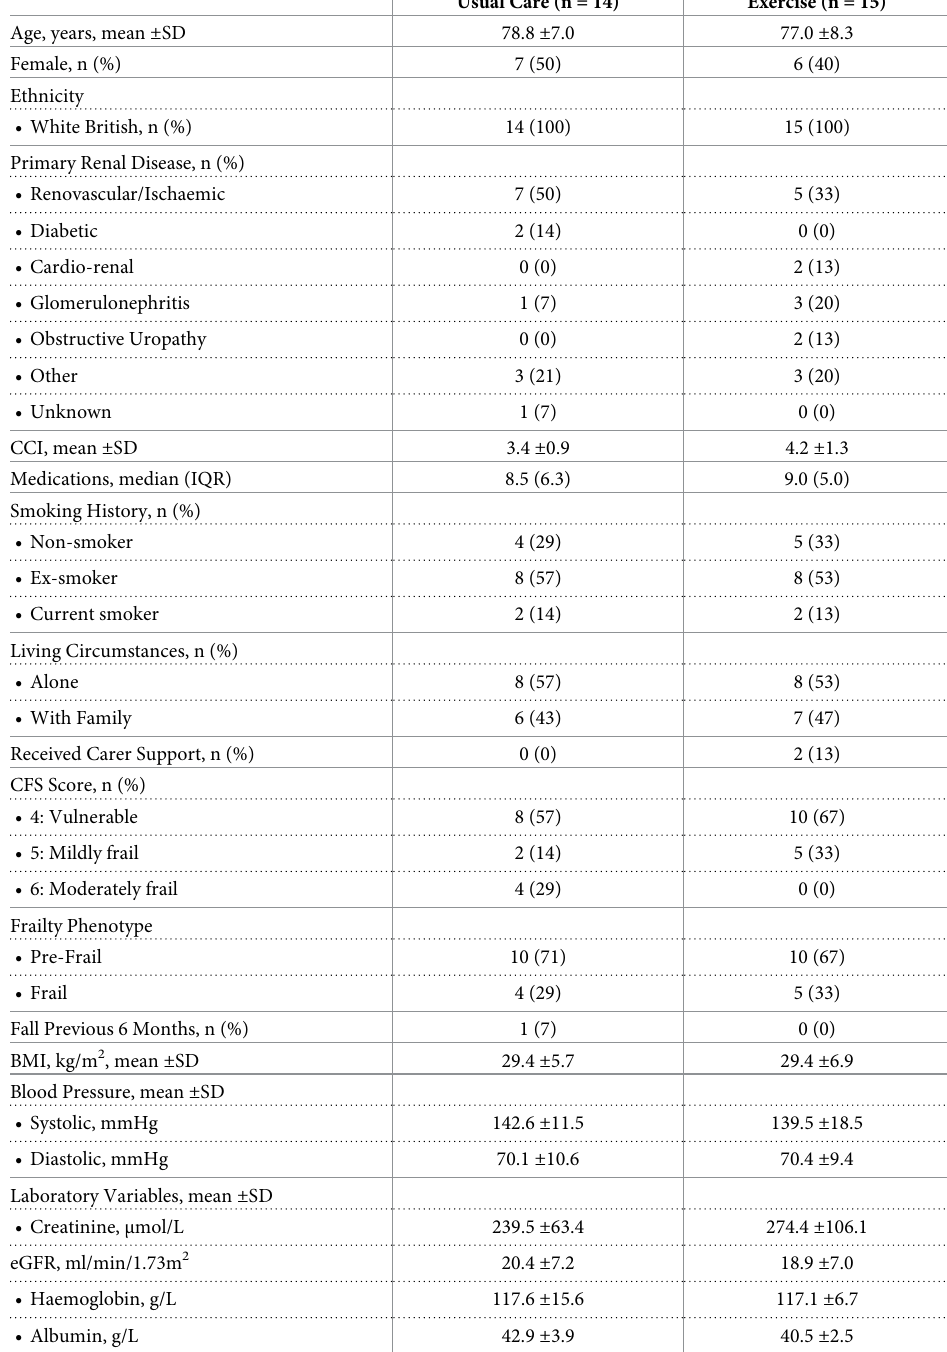
Table 2. Participant demographics and clinical